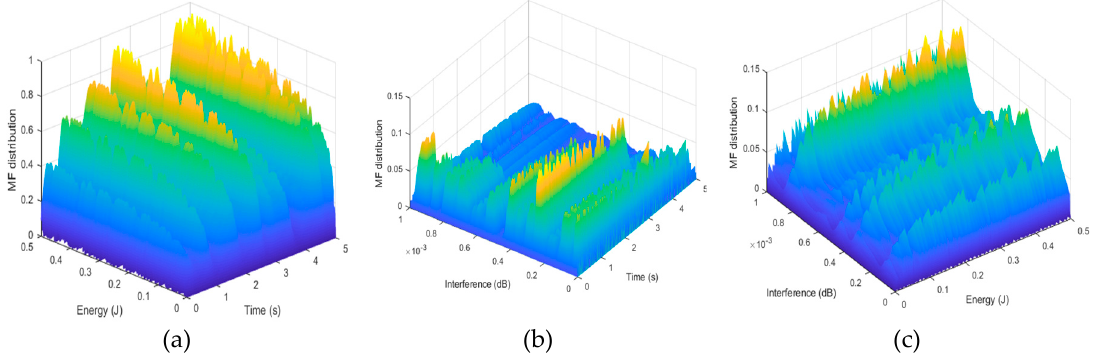
Figure 4. Mean field distributions for respective scenarios ( a ) β max = 6 × 10 − 6 W, ( b ) E max = 0.5 J, ( c ) T = 5 s.